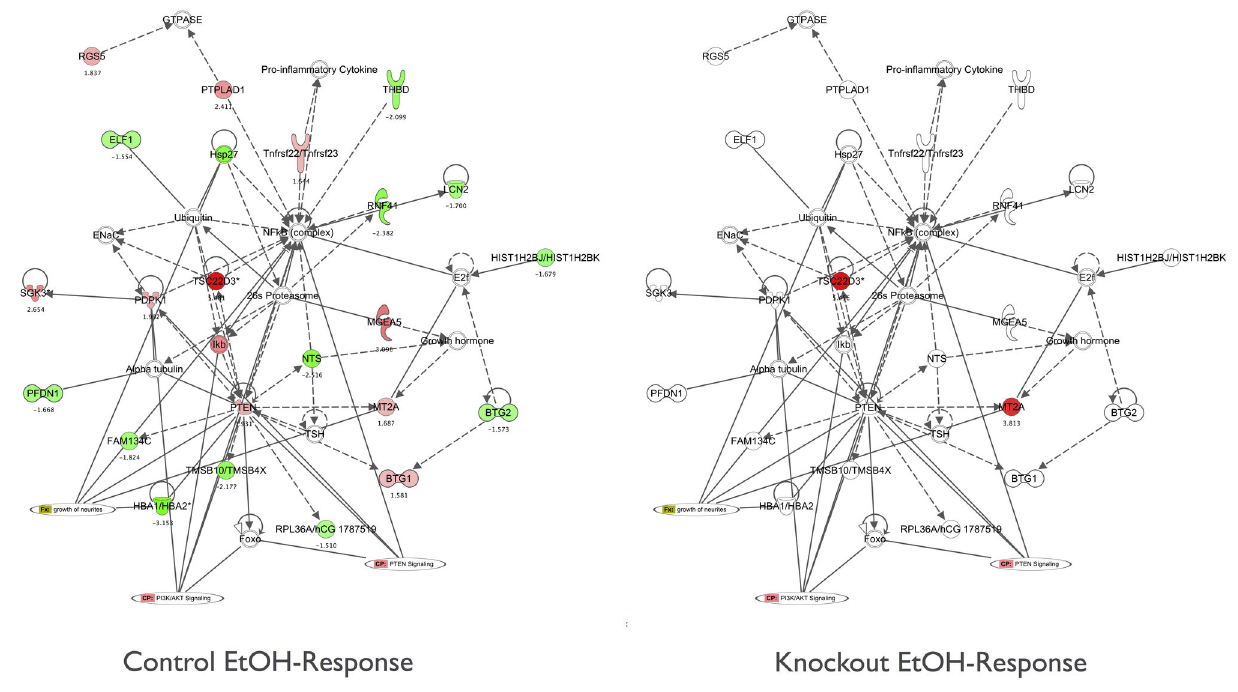
Figure 3. Fyn Knockout Animals Have Altered Ethanol-Responsive Gene Networks. Ingenuity Pathway Analysis from two- class SAM filtering for network-level differences in ethanol-responsive gene expression for the Nucleus Accumbens in control (left panel) versus Fyn knockout (right panel) mice. Genes labeled in green are down-regulated by acute ethanol; Red labeled genes are up-regulated by acute ethanol. Numbers shown are the mean S-score for 3 biological replicates. Data for additional brain regions are shown in Figure